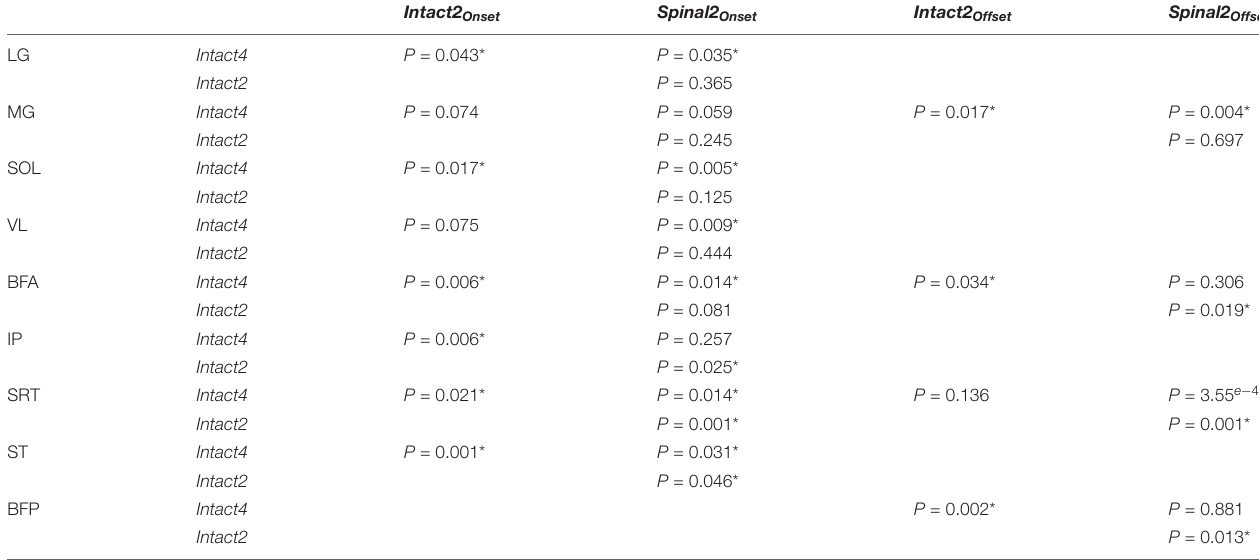
TABLE 3 | Effect of locomotor conditions and state on EMG phasing. Intact2 Onset Spinal2 Onset Intact2 Offset Spinal2